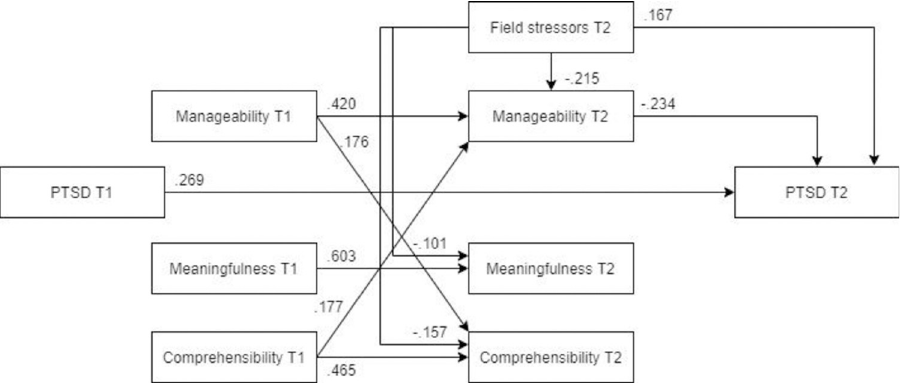
Fig 15. Optimized structural equation model for